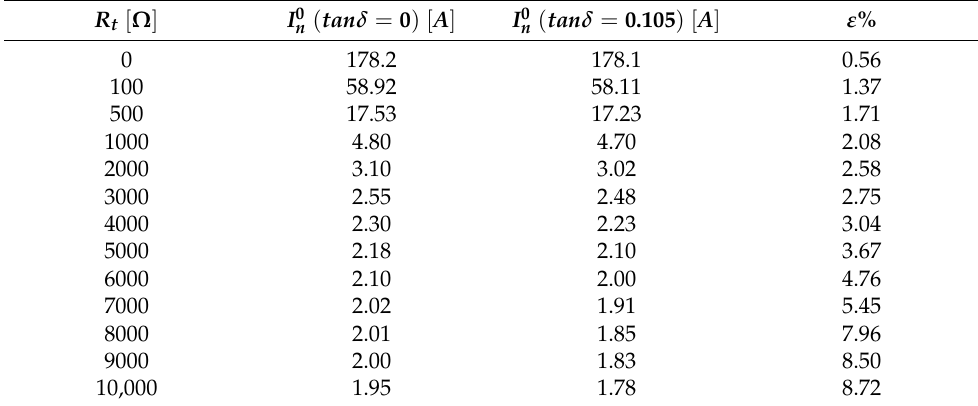
Table 5. Influence of insulation state on current I 0 n , when U 0 e = 575